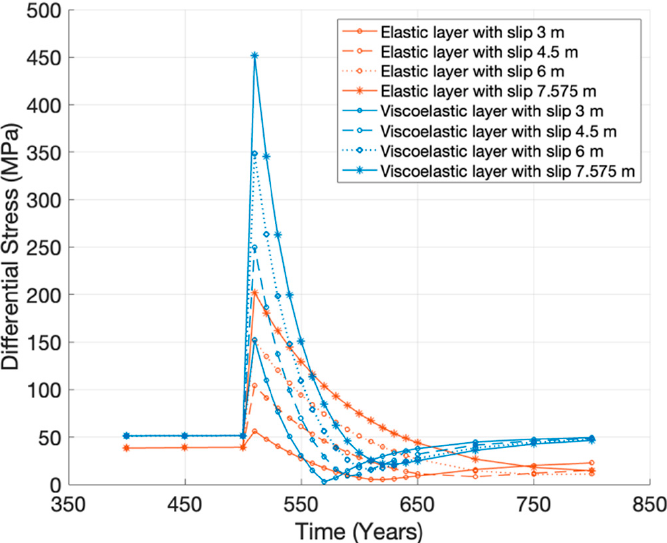
Figure 9. Differential stress of strain release model on the boundary of each layer with varied slip magnitudes (3 m, 4.5 m, 6 m, and 7.575 m).